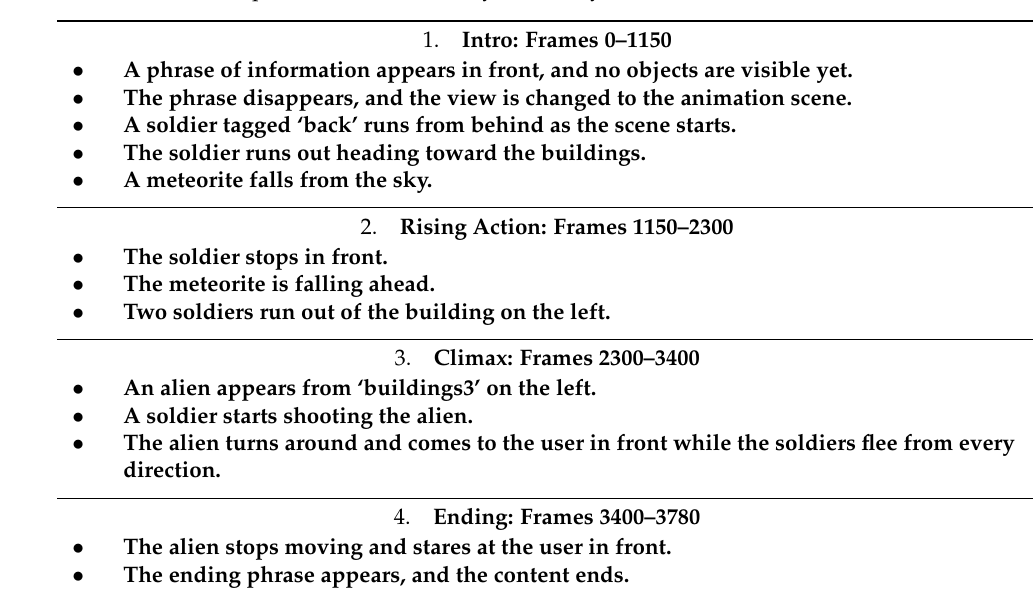
Table 1. An overall plot of the virtual reality (VR) story.